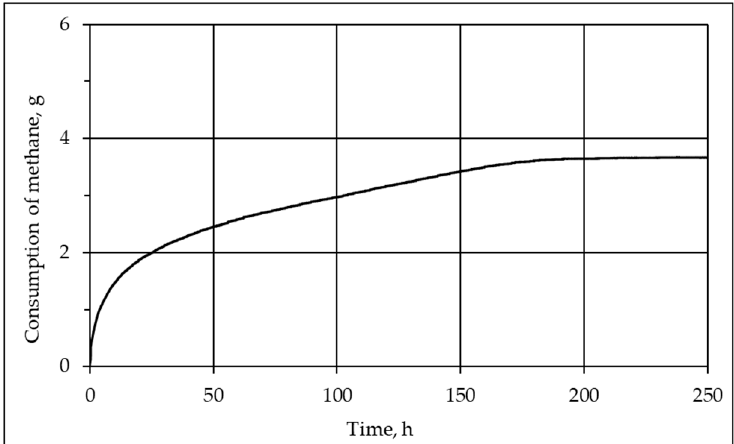
Figure 3. Consumption of methane during the hydrate formation in sample silt 2 ( W = 20%, Si = 59%) at t = (cid:442) 2.5 °C.